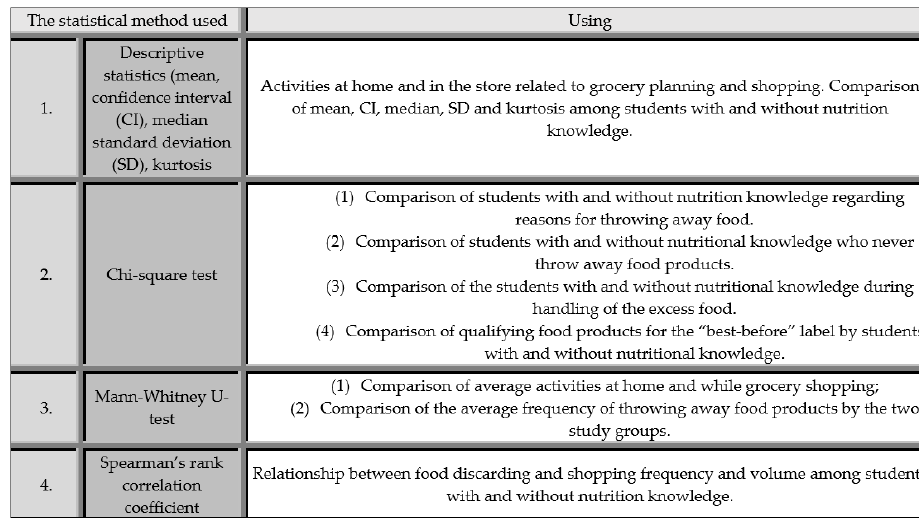
Figure 2. The statistical method used.